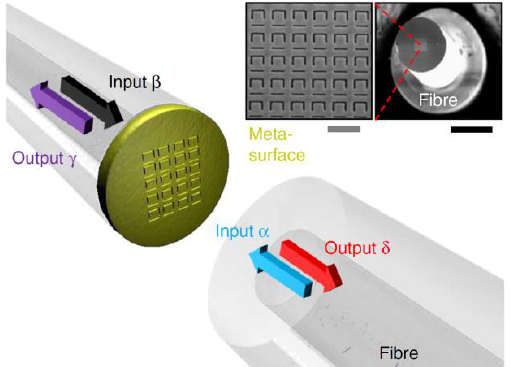
Figure 7. Coherent interaction of light with a metasurface. Coherent optical input signals α and β interact on a metasurface absorber and generate output signals γ and δ . The metasurface was fabricated by nanostructuring the central 25 × 25 µ m 2 of a 70-nm-thick gold layer covering the cleaved end face of a polarization-maintaining single-mode silica fiber (inset scanning electron microscope images, black scale bar of 100 μm, gray scale bar of 1 μm). Reproduced with permission from [63].